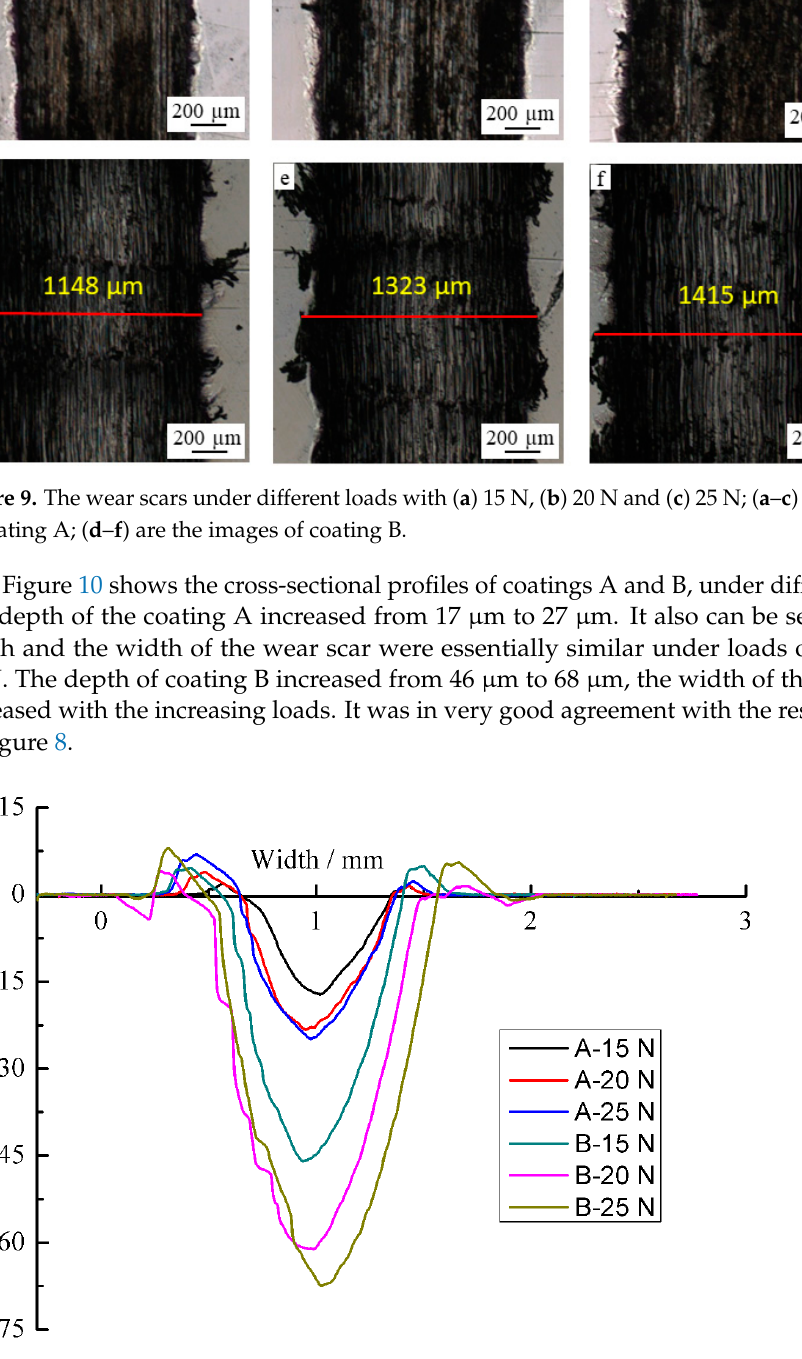
Figure 10. Two-dimensional (2D) profiles s of the cross-section of the wear